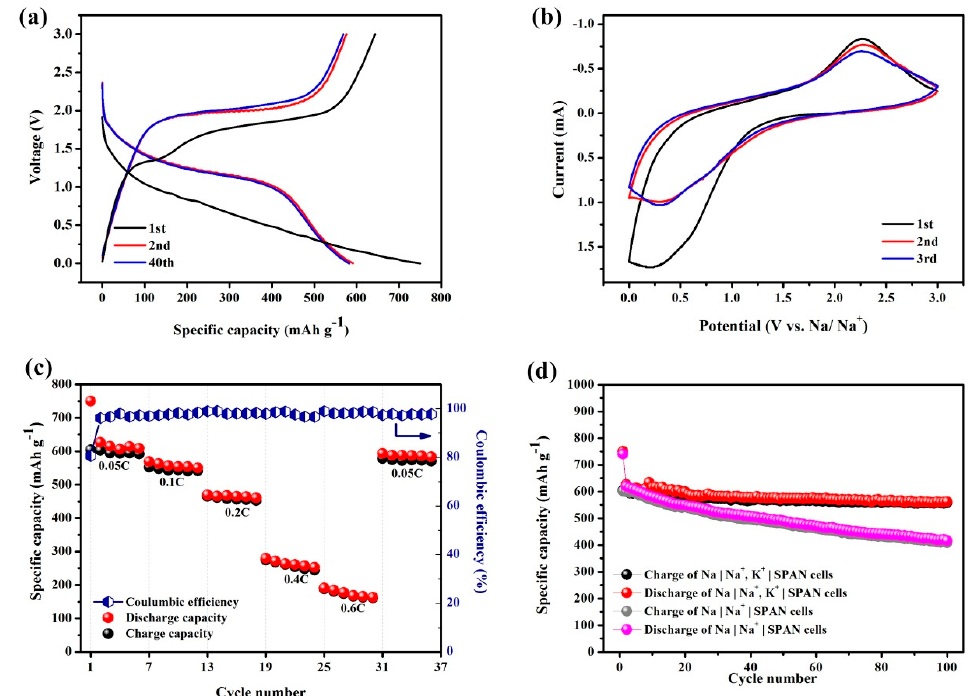
Figure 2. Electrochemical performance of a Na|Na + and K + |SPAN cell. ( a ) Galvanostatic discharge–charge voltage profiles of the hybrid Na + /K + battery at a current density of 35 mA g − 1 , ( b ) cyclic voltammetry (CV) curves at 0.5 mV s − 1 for the first three cycles, ( c ) rate performance, and ( d ) cycle performance of Na|Na + , K + |SPAN, and Na|Na + |SPAN cell.